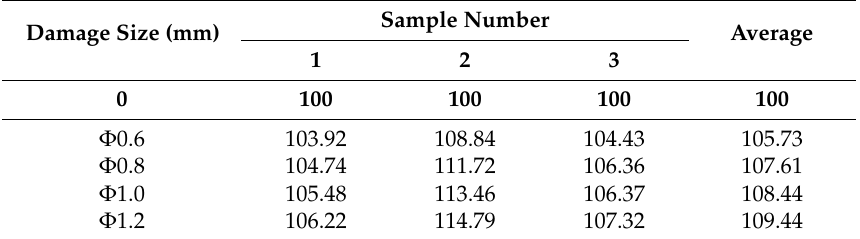
Table 3. Normalized ultrasonic energy dissipation coefficient of damage category D1 (unit: %). Damage Size